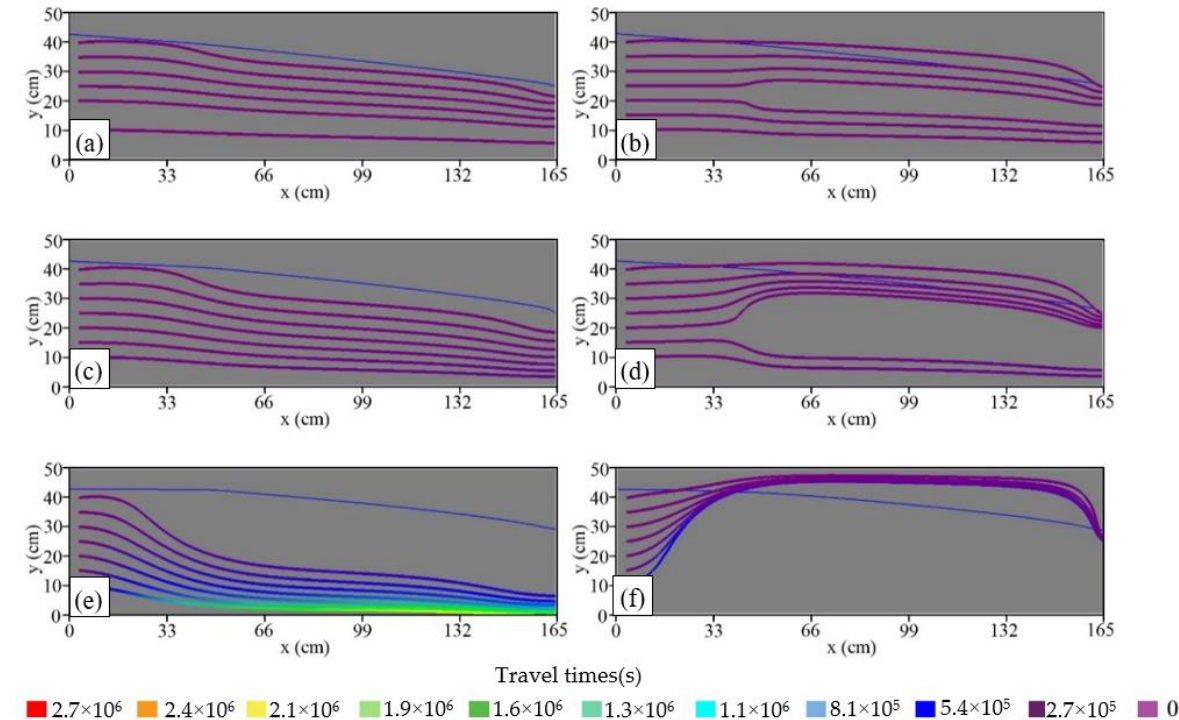
Figure 14. Ambient groundwater flow paths associated with travel time produced by artificial recharge and different depth-decay exponents. The left panel of figures were produced by the infiltration basin and the right panel of figures were produced by injection well IW3. The depth-decay exponents in ( a ) and ( b ) were set to 0.01 m −1 . The depth-decay exponents in ( c ) and ( d ) were set to 0.05 m −1 . The depth-decay exponents in ( e ) and ( f ) were set to 0.1 m −1 . The blue lines in the figures represent the water table.